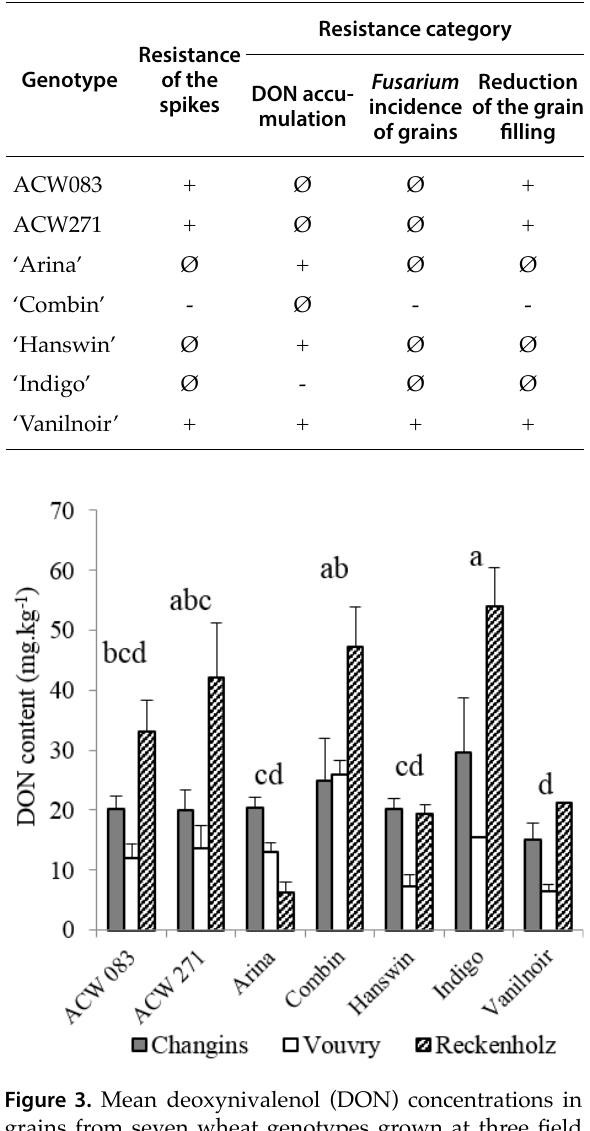
Table 4. Classification of the different types of resistance for the wheat genotypes used in this study. + = resistant, - = susceptible, and Ø = non-significant resistant comport - ment.